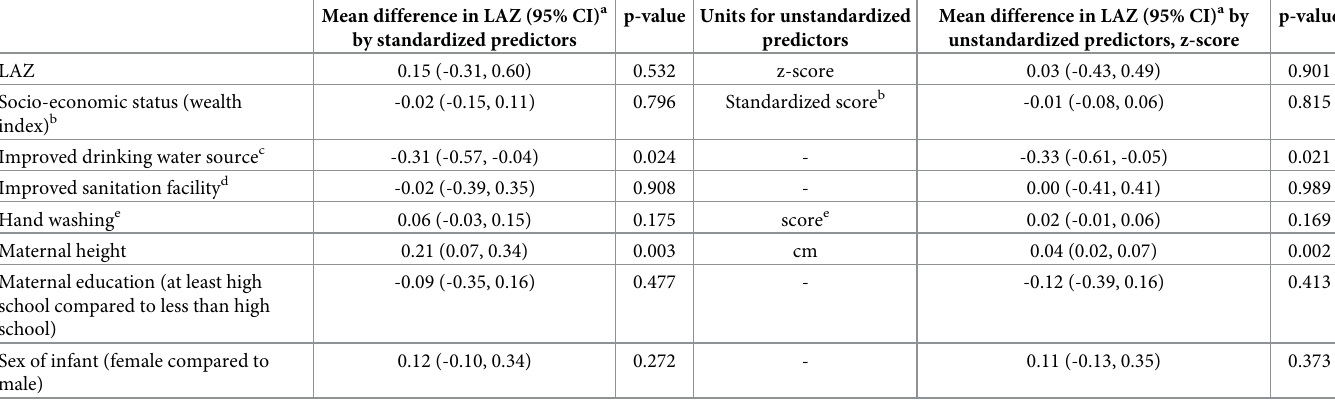
Table 4. Demographic predictors of length-for-age z-score (LAZ) between 6 and 12 months of age (n = 225). Mean difference in LAZ (95% CI) a p-value Units for unstandardized by standardized predictors